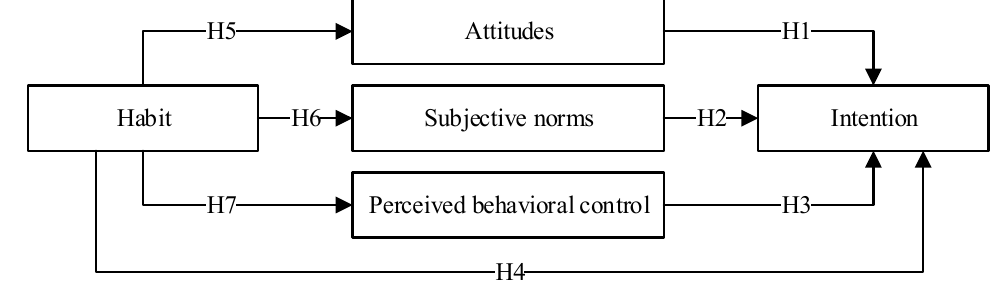
Figure 3. Theory of planned behavior (TPB) extension theory model.